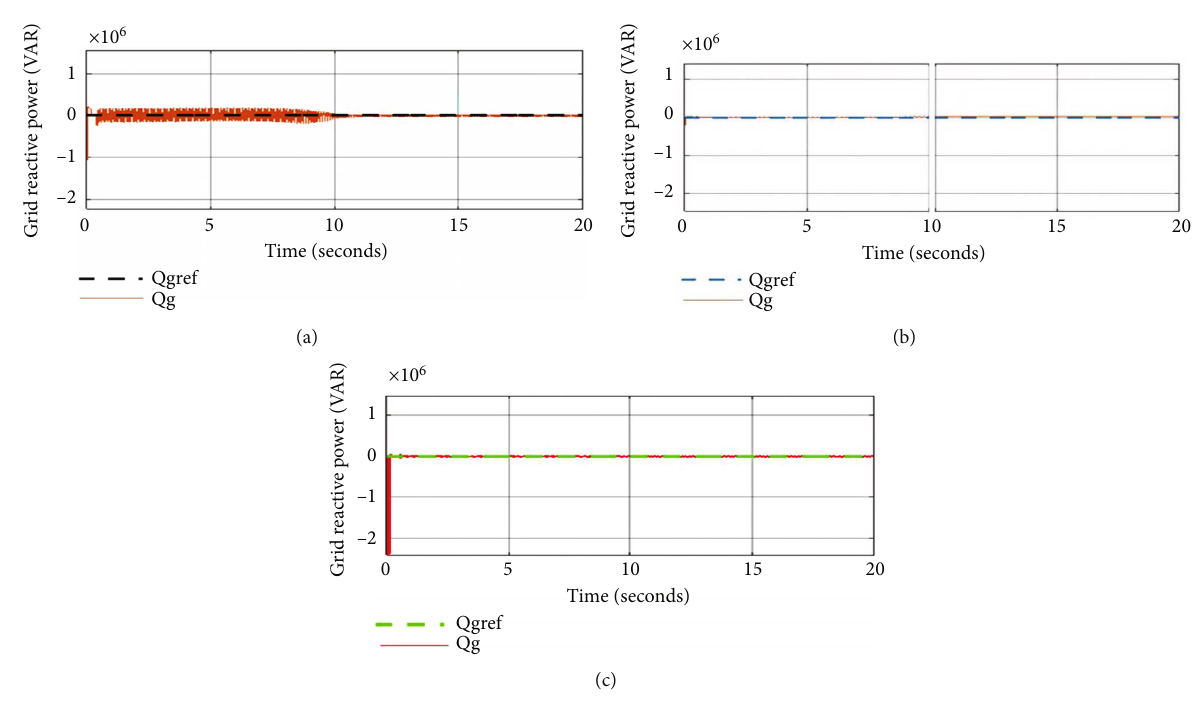
Figure 19: (a – c) Grid reactive powers with their